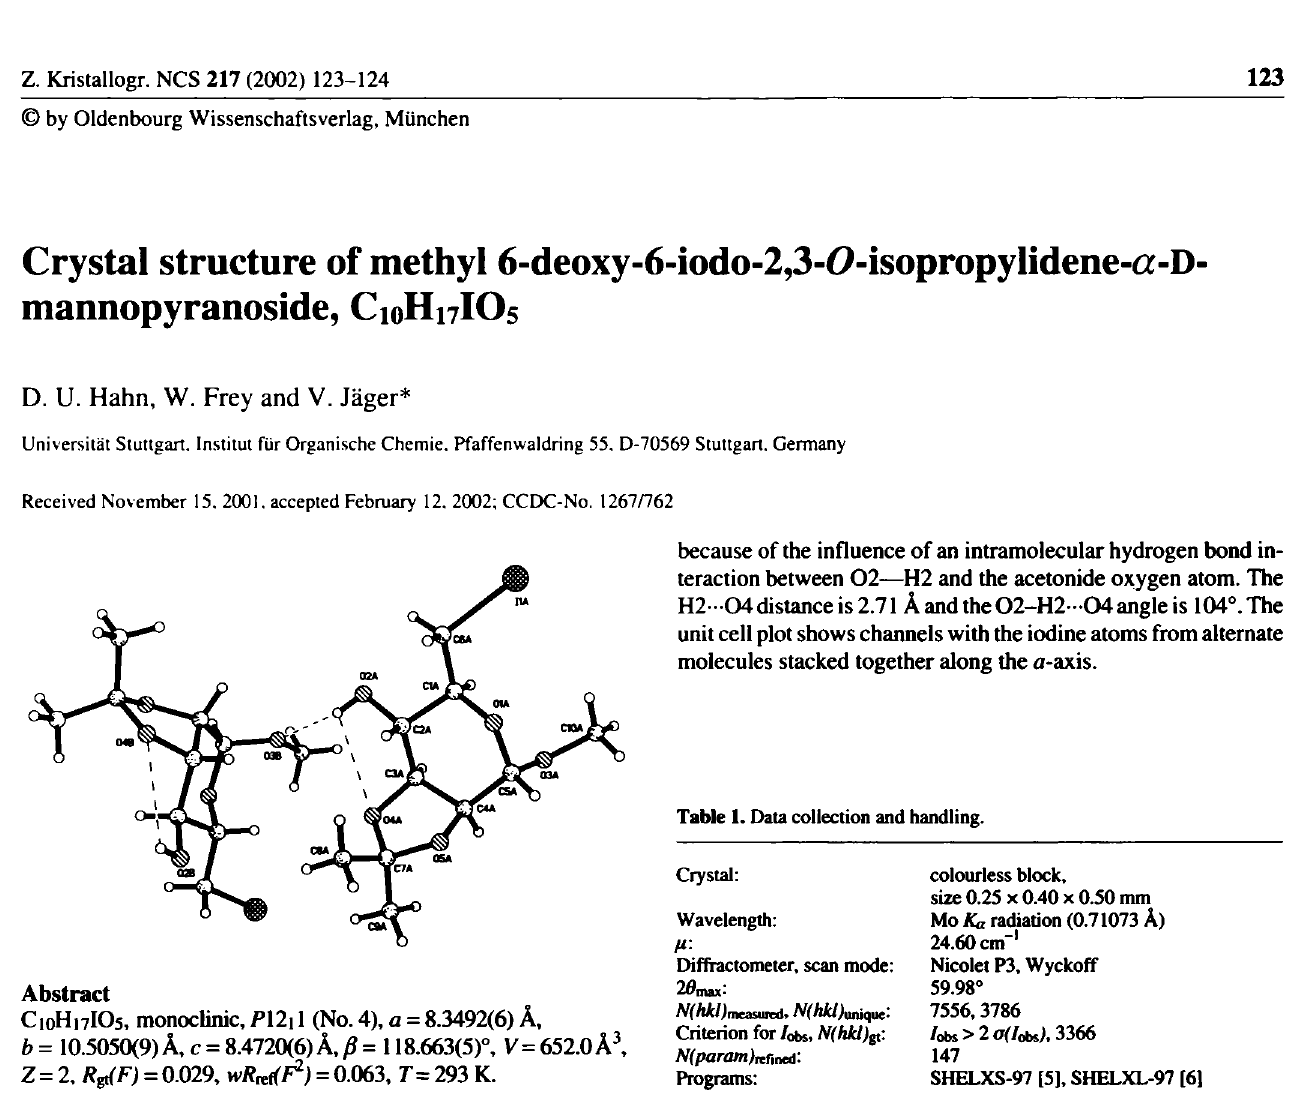
Table 2. Atomic coordinates and displacement parameters (in A 2